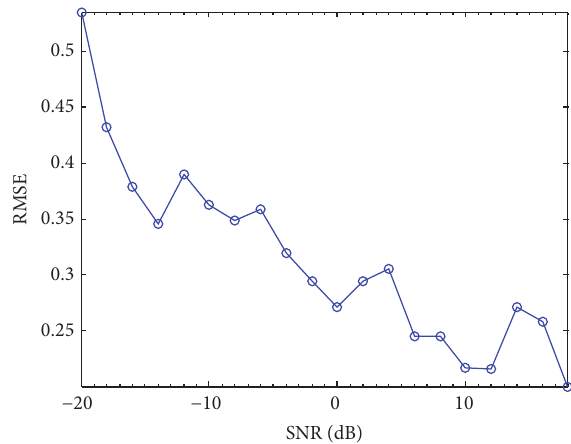
Figure 8: The RMSE versus SNR for the ExCoV method.